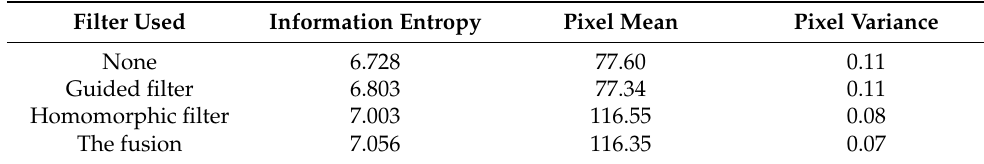
Table 2. Ablation study results of two filter